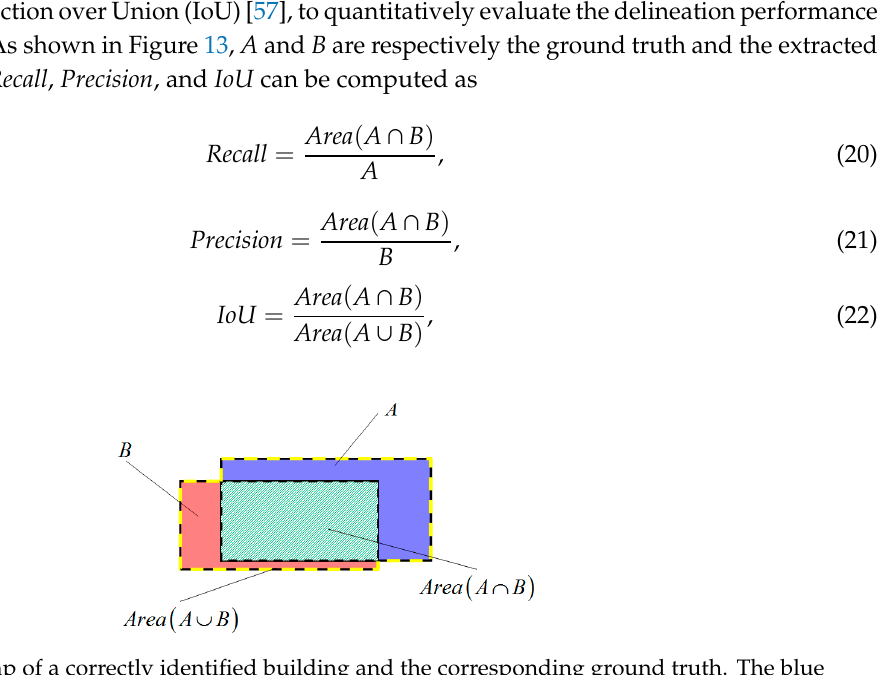
Figure 13. Overlap of a correctly identified building and the corresponding ground truth. The blue area is the ground truth. Green area is the intersection part of A and B , and the area within the yellow line is the union of A and B .